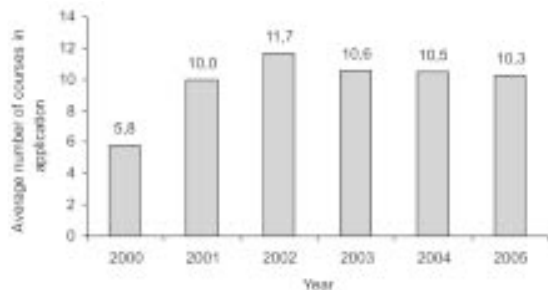
Fig 2. Average number of selected courses mentioned in school-leaver’s application